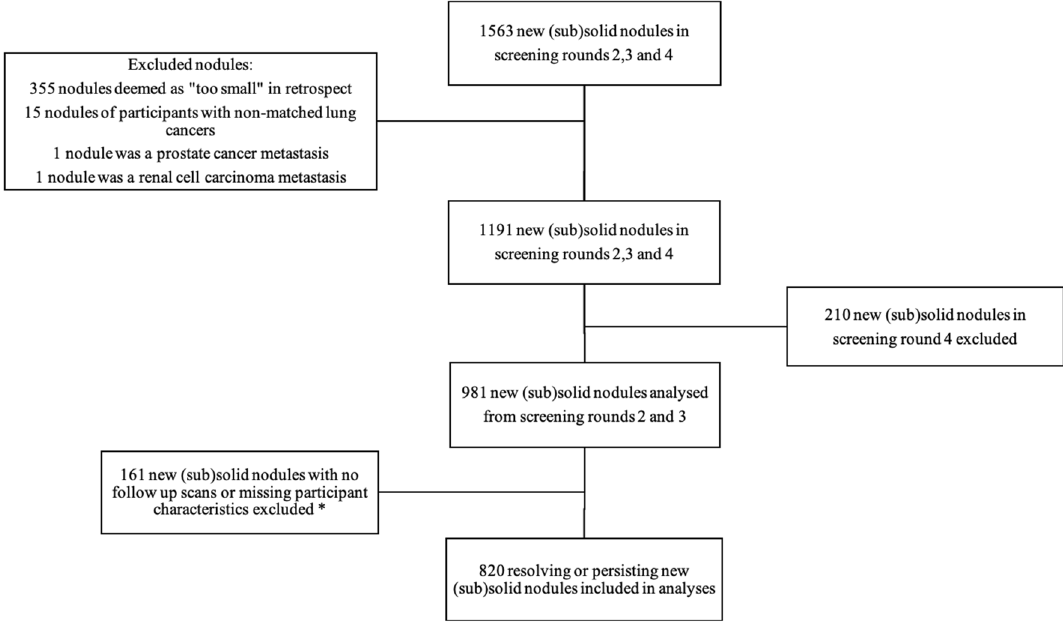
Figure 1. Overview of new resolving and persisting (sub)solid lung nodules included in this sub-study of the NELSON trial. *a nodule had no follow up scan when a participant was referred immediately to a pulmonologist for further diagnostics, or the participant did not require an additional CT scan according to